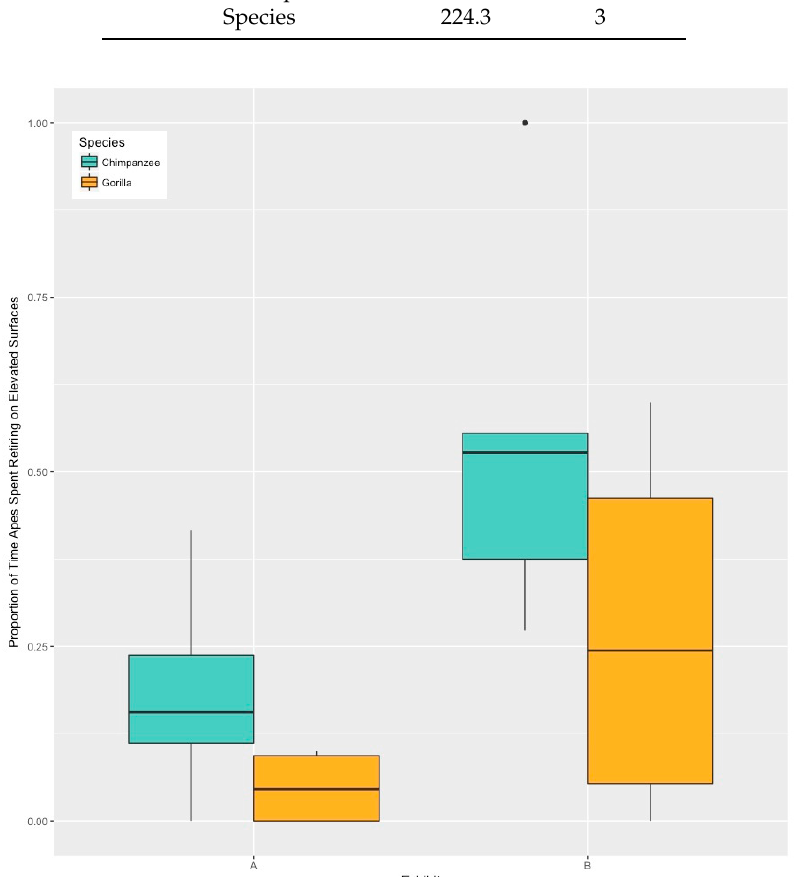
Figure 3. Proportion of time the chimpanzees and gorillas performed retiring behaviors on elevated surfaces in Exhibit A and Exhibit B.